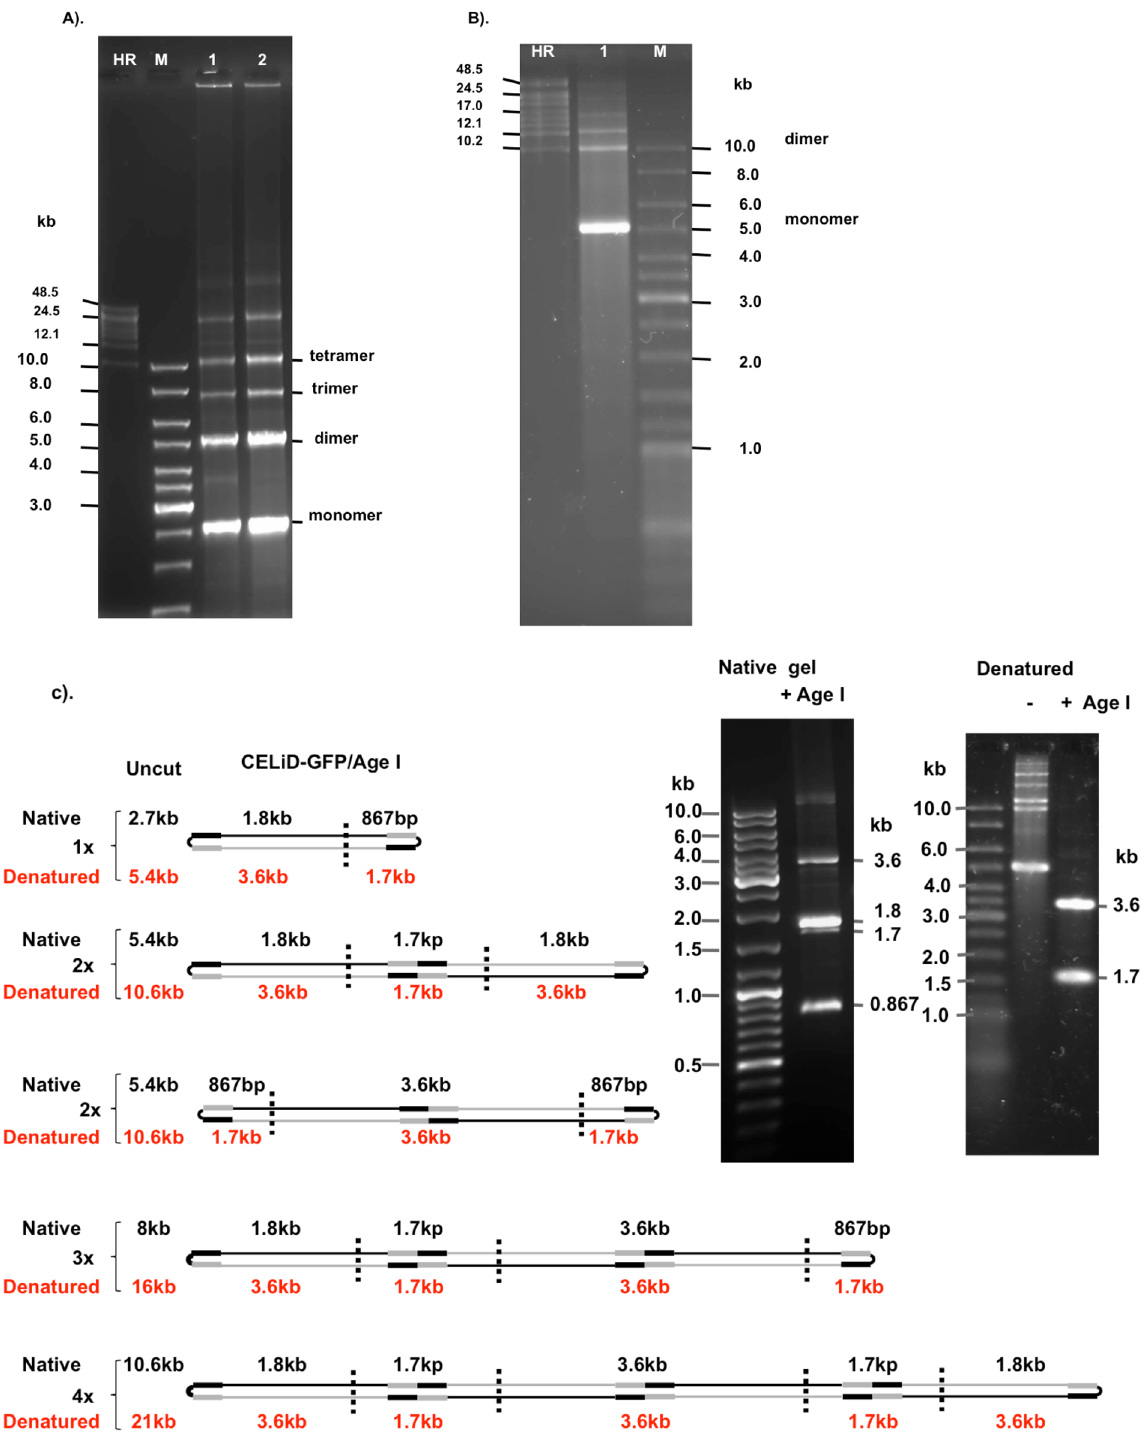
Figure 4. Native and denaturing agarose gel electrophoresis of CELiD-GFP DNA. (A) Native agarose gel electrophoresis (0.4% agarose, 1x TAE buffer). CELiD DNA resolved as a 2.7 kb monomer and associated multimeric concatomers. Lane 1: CELiD-GFP DNA produced from co-infecting parental Sf9 cells with Bac-Rep and a baculovirus bearing an AAV ITR-flanked GFP cassette, Bac-GFP. Lane 2: CELiD-GFP DNA produced from an Sf9/ ITR-GFP cell line bearing a stably integrated AAV GFP vector genome. M: 1 kb DNA ladder. HR: high-range DNA ladder. The positions of various replicative-form CELiD DNAs are indicated: monomer, dimer, trimer, and tetramer. (B) Denaturing agarose gel electrophoresis (0.7% alkaline agarose). CELiD-GFP DNA conformers appear predominantly as a 5.4 kb band, with dimer and higher order forms detectable. (C) Restriction map. Restriction endonuclease AgeI has one recognition site in the CELiD monomer, generating two fragments of 1801 bp and 867 bp, respectively. Schematic representation of the AgeI recognition site(s) in the monomer (1x), dimer (2x) and multimer (3x and 4x) forms of CELiD-GFP DNA. CELiD-GFP monomer: 2668 bp. The black rectangles indicate the positions of the AAV 5 9 ITRs, and the gray rectangles indicate the positions of the AAV 3 9 ITRs. The two dimer figures represent tail-to-tail and head-to-head configurations. The predicted DNA length and fragments are indicated. Top right,